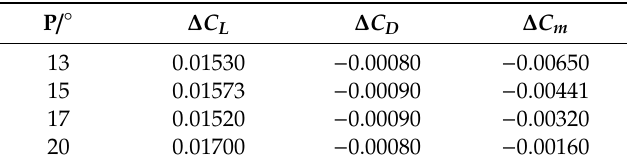
Figure 12. Support interference results of the BWB aircraft with different inflection angles (P = 13 ◦ / 15 ◦ / 17 ◦ / 20 ◦ , Ma = 0.75): ( a ) C L - α curves; ( b ) C D - α curves; ( c ) C m - α curves. Table 9. Interference results of the BWB aircraft with di ff erent inflection angles (P = 13 ◦ / 15 ◦ / 17 ◦ / 20 ◦ , Ma = 0.75, α = 0 ◦ ).